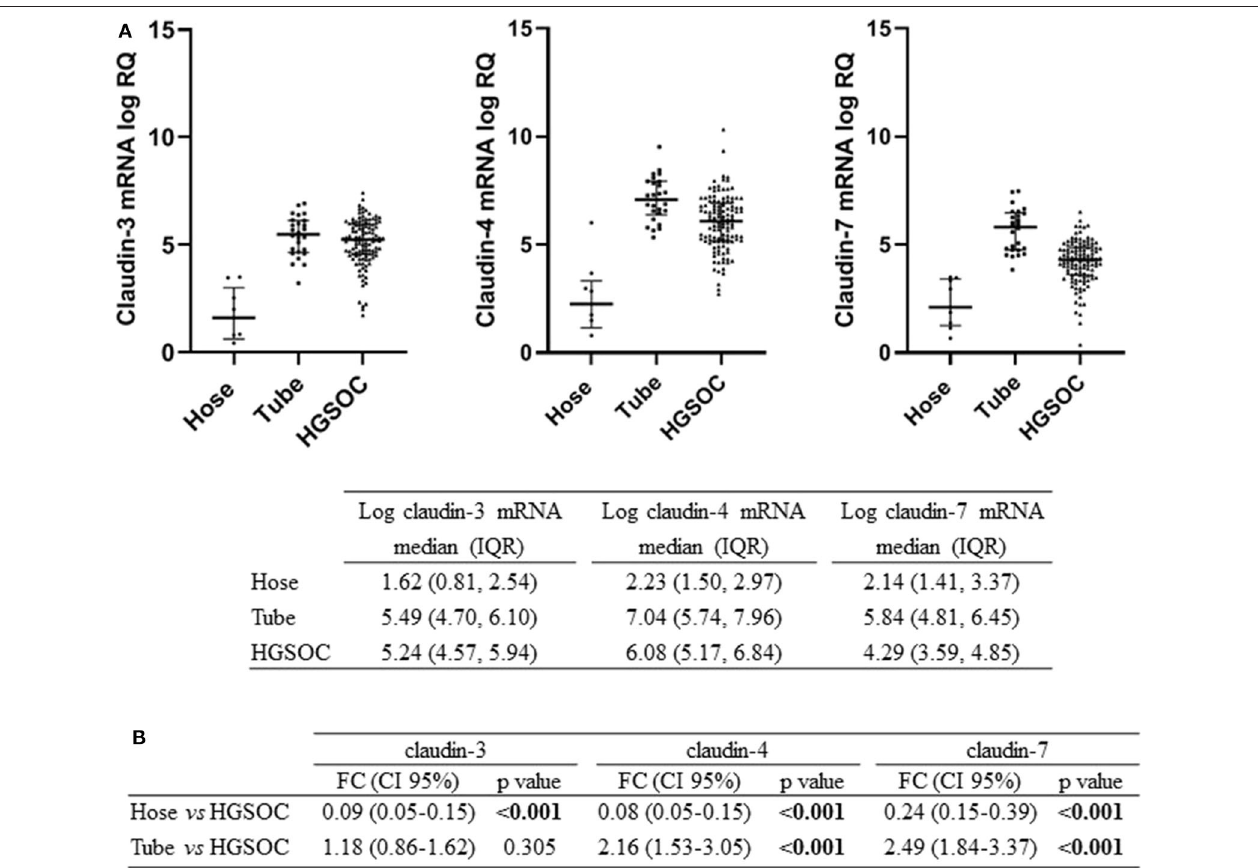
FIGURE 1 | Expression of claudin-3,-4, -7 in normal ovarian surface epithelium (Hose, n = 9), normal tube epithelium (Tube, n = 26) and ovarian tumors (HGSOC, n = 105). (A) mRNA expression data are shown as scatter dot plot where the solid lines represent the median with interquartile range (IQR). Value are given as normalized expression relative quantification (log RQ). (B) Fold change (FC) is calculated by dividing mean expression in either Hose or tube by the one in HGSOC tissues. Significant comparisons are indicated by bold font.